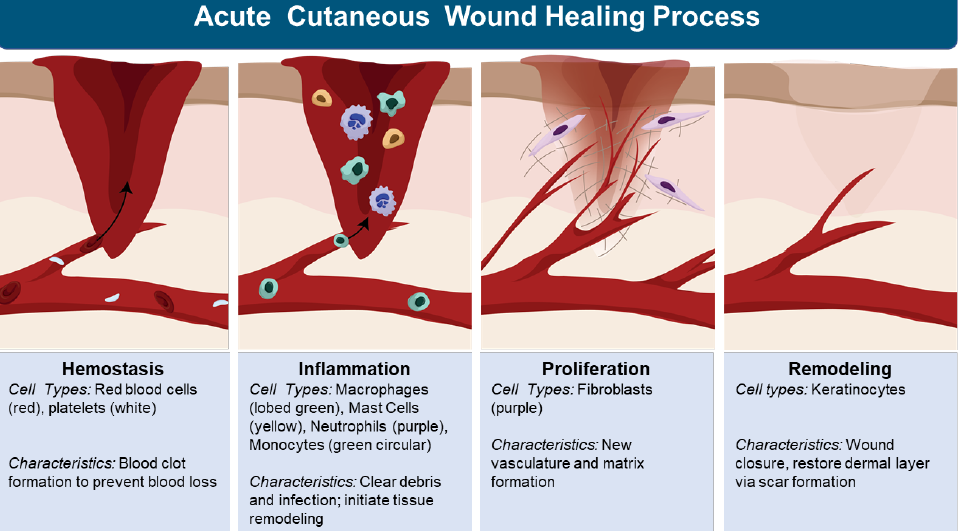
Figure 2. Acute cutaneous wound repair occurs in four well defined stages: hemostasis [6,33,35,39], inflammation [6,33,35,39,41], proliferation [40], and remodeling [6,32,34,42], which are mediated by distinct cell populations.